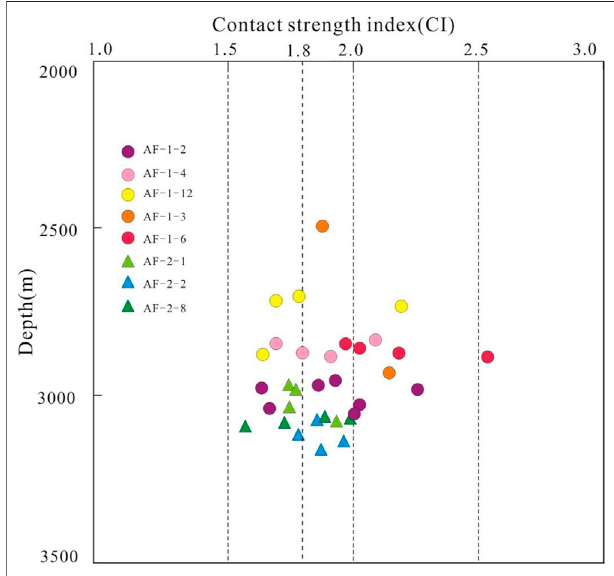
FIGURE10| The relationships ofcontact strength index (CI) vs. depth in eight wells from the AF-1 area and the AF-2